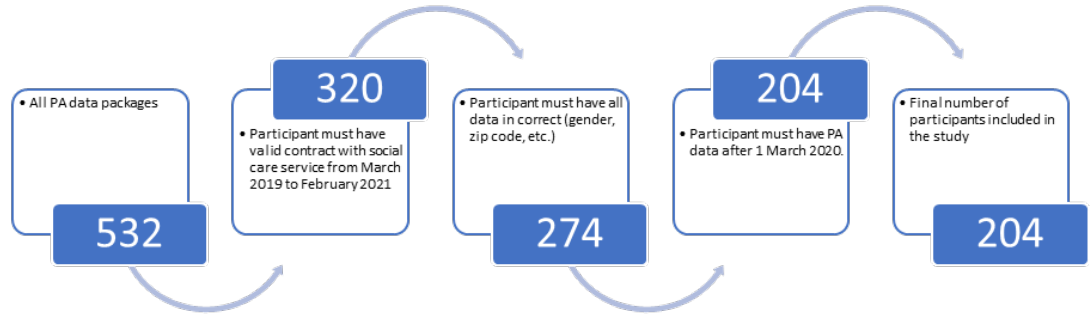
Figure 1. The process of filtering participants leading to the final